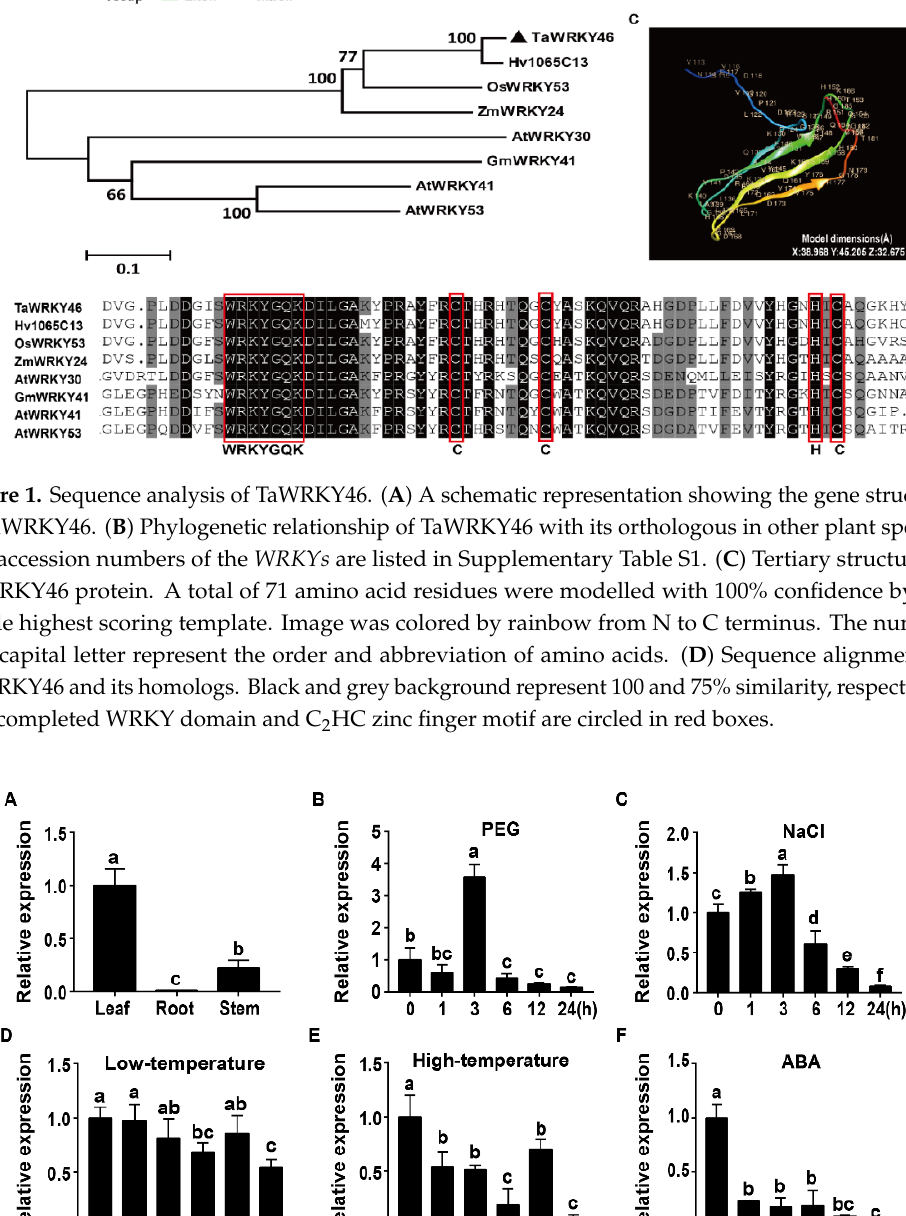
Figure 2. Transcription profiles of TaWRKY46 . ( A ) Organ expression assay of TaWRKY46 in different wheat organs (leaf, root, and stem). Transcription profiles of TaWRKY46 under 20% PEG 6000 ( B ); 200 mM NaCl ( C ); 4 C° ( D ); 42 C° ( E ); 100 μM ABA ( F ) treatments in wheat leaves. The transcriptional level at time point 0 (for the multiple stress experiments) and the leaf (for the organ expression assay) was defined as 1.0.